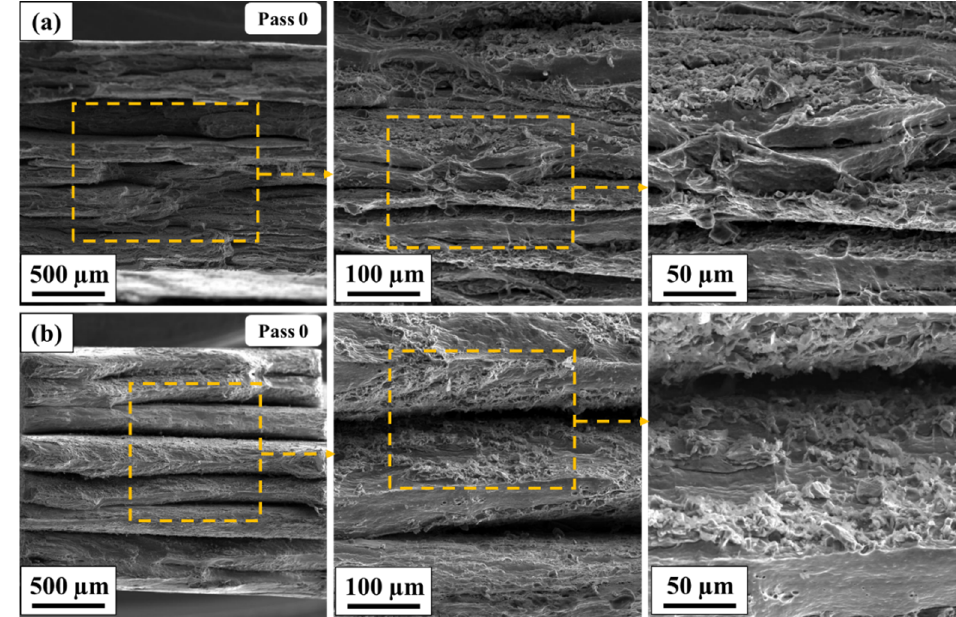
Figure 11. Fracture surfaces of Al/Cu/3wt%SiC composites fabricated by: ( a ) ARB and ( b ) CARB process.